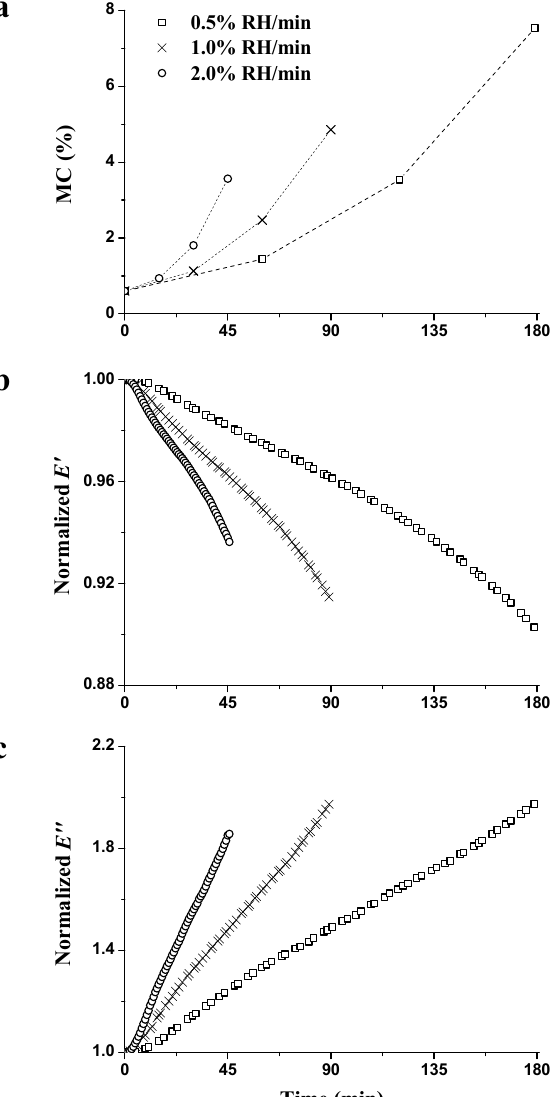
Figure 4. Changes of wood MC ( a ); n E ′ ( b ); and n E ″ ( c ) during the RH ramp period (0% → 90% RH) with different RH ramping rates measured at 1 Hz.